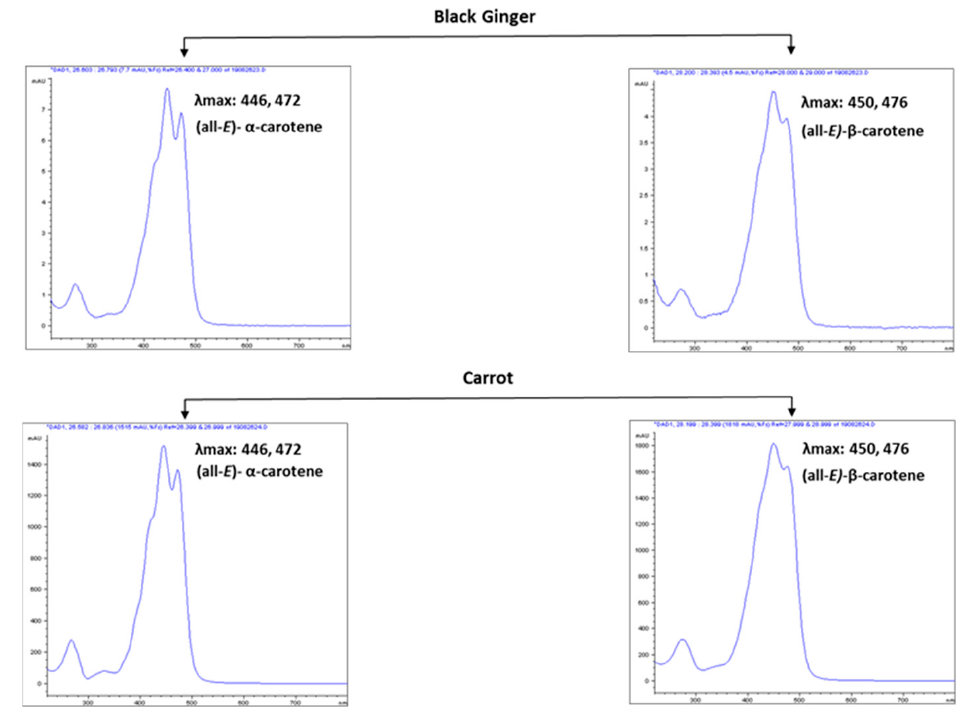
Figure 4. Absorption spectra recorded by diode array detector (DAD).